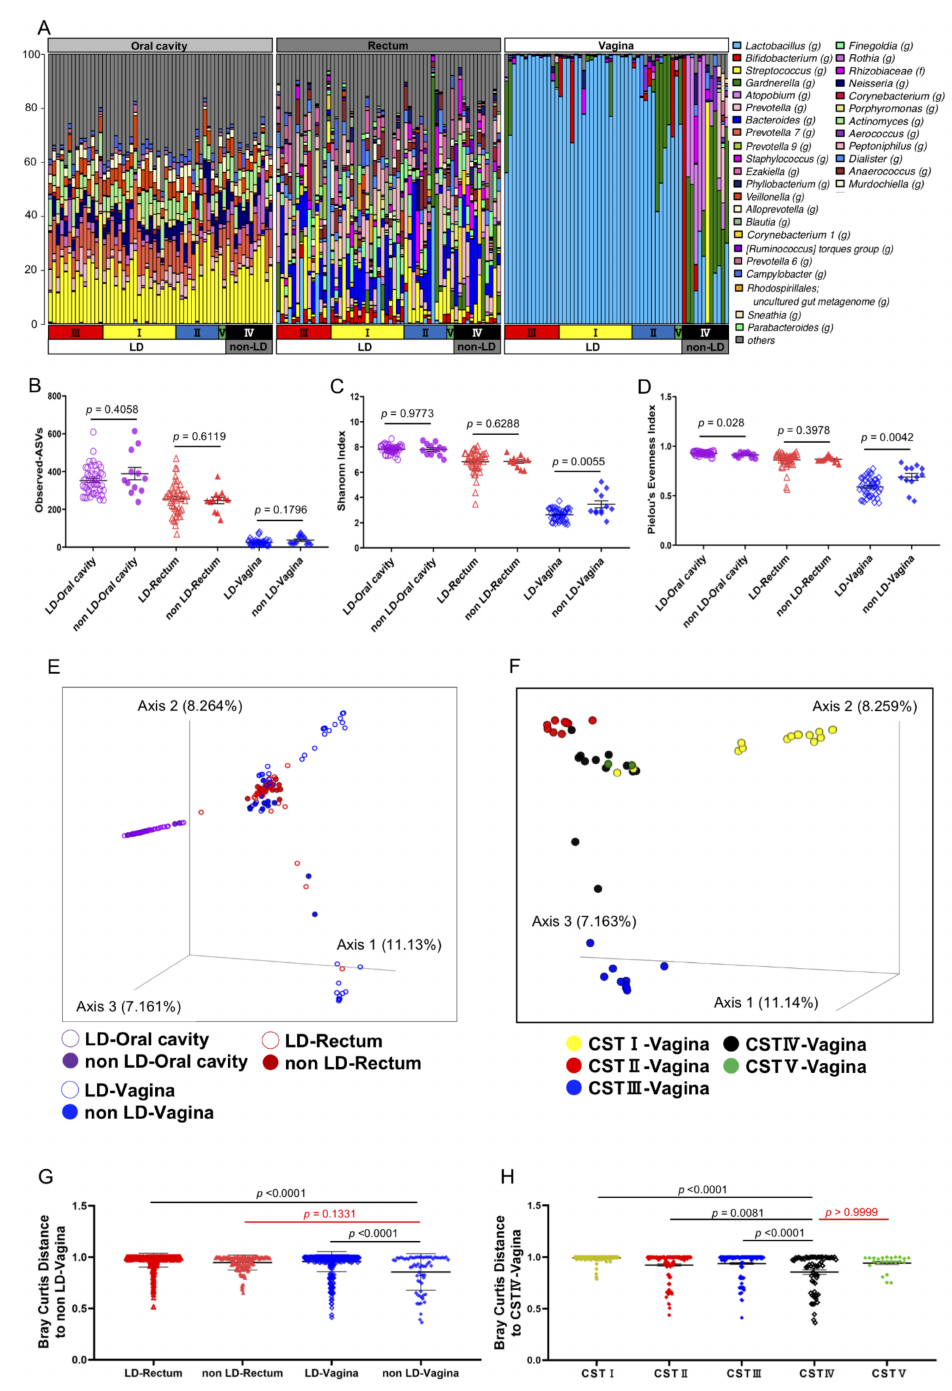
Figure 2. Integrated analysis of oral, vaginal, and rectal microbiota. The microbiome from the oral cavity, vagina, and rectum from 58 pregnant women including Lactobacillus -dominated vaginal microbe group (LD group) and non- Lactobacillus -dominated vaginal microbe group (non-LD group) were determined using 16S rRNA gene sequencing analysis. ( A ) The taxonomic distribution of the individual microbes is shown at the genus level. The taxon was defined as “others” if the maximum value of percentage was less than 10% in each sample. The Richness, Diversity and Evenness of samples (non-LD ( n = 12), LD ( n = 46)) as derived using observed ASVs ( B ), Shannon Index ( C ), Pielou’s Evenness Index ( D ), Bray–Curtis ( E , F ), Bray–Curtis distance to non-LD group ( G ), to